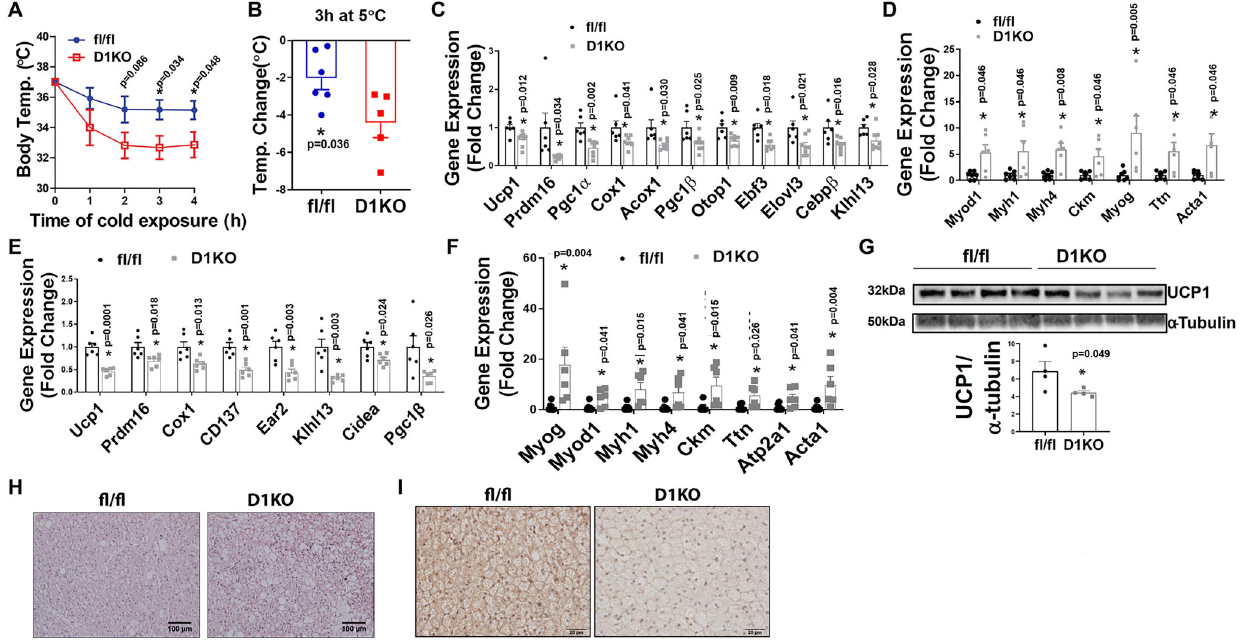
Fig. 6 DNMT1 de fi ciency in brown fat impairs cold-induced thermogenesis. A Body temperature in male chow-fed 2-month-old D1KO and fl / fl mice during acute 5 °C cold exposure ( n = 6 for fl / fl and 5 for D1KO). *Indicates statistical signi fi cance between fl / fl and D1KO as analyzed by two-tailed unpaired Student ’ s t -test. B Body temperature change in male chow-fed 2-month-old D1KO and fl / fl mice after 3 h of cold exposure ( n = 6 for fl / fl and 5 for D1KO). *Indicates statistical signi fi cance between fl / fl and D1KO as analyzed by two-tailed unpaired Student ’ s t -test. C , D Quantitative RT-PCR analysis of BAT-speci fi c gene expression ( C , n = 6 for fl / fl and 8 for D1KO), and myogenic gene expression ( D , n = 7 for fl / fl and 6 for D1KO) in iBAT of male chow- fed 2-month-old D1KO and fl / fl mice after an acute 4-h 5 °C cold exposure. *Indicates statistical signi fi cance between fl / fl and D1KO as analyzed by two- tailed unpaired Student ’ s t -test in ( C ) and Mann – Whitney ’ s nonparametric U test in ( D ). E , F Quantitative RT-PCR analysis of BAT-speci fi c gene expression ( E , n = 6/group), and myogenic gene expression ( F , n = 6/group) in iBAT of male chow-fed 2-month-old D1KO and fl / fl mice after a chronic 7-day 5 °C cold exposure. *Indicates statistical signi fi cance between fl / fl and D1KO as analyzed by two-tailed unpaired Student ’ s t -test in ( E ) and Mann – Whitney ’ s nonparametric U test in ( F ). G Immunoblotting of UCP1 protein in iBAT of male chow-fed 2-month-old D1KO and fl / fl mice after a 7-day 5 °C cold exposure ( n = 4/group). *Indicates statistical signi fi cance between fl / fl and D1KO as analyzed by two-tailed unpaired Student ’ s t -test. H , I Representative H&E staine ( H ) and UCP1 IHC staining ( I ) in iBAT from male chow-fed 2-month-old D1KO and fl / fl mice after a chronic 5 °C 7-day cold exposure ( n = 3 replicates for each group). All data are expressed as mean ±